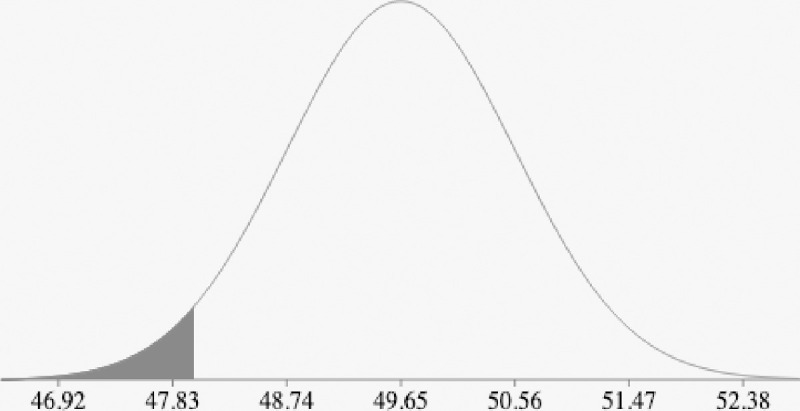
The normal distribution with mean 49.65 and standard deviation 0.91.Then P (X<48; X < min g(X)) = 0.0349.